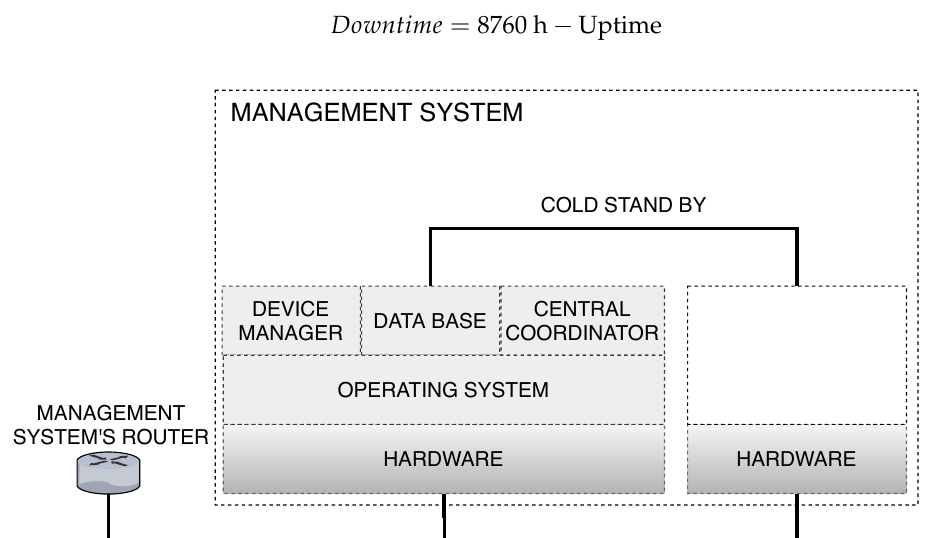
Figure 7. Local management